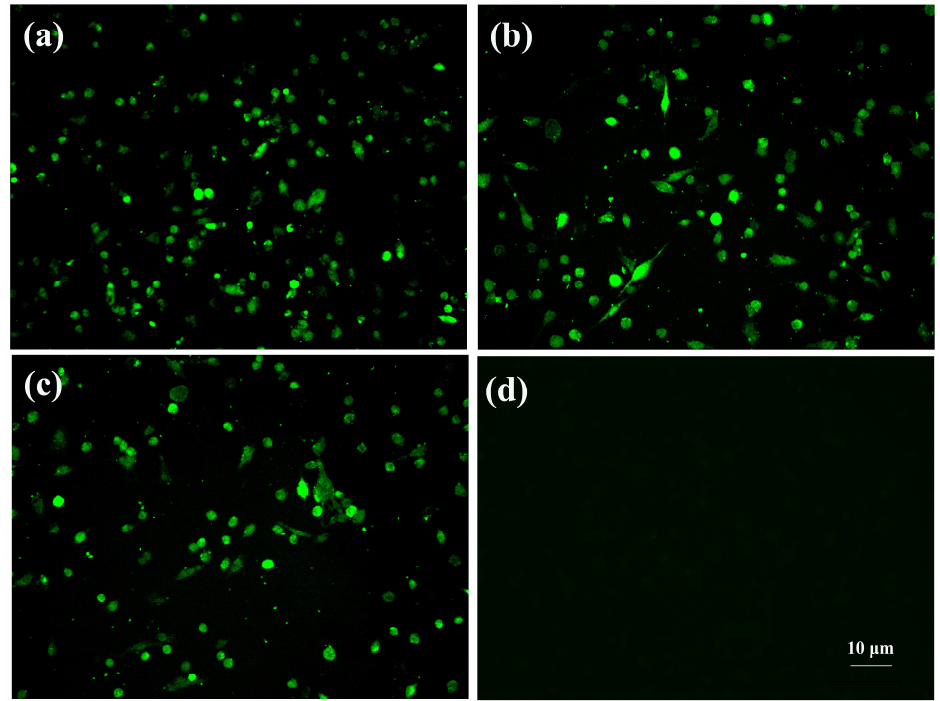
Figure 1. The results of the IFA. ( a ) PAMs inoculated with SCcd16; ( b ) PAMs inoculated with SCya17; ( c ) positive control cells inoculated with SCwhn09CD; ( d ) uninfected negative controls for PAMs. Scale bar = 10 μm.